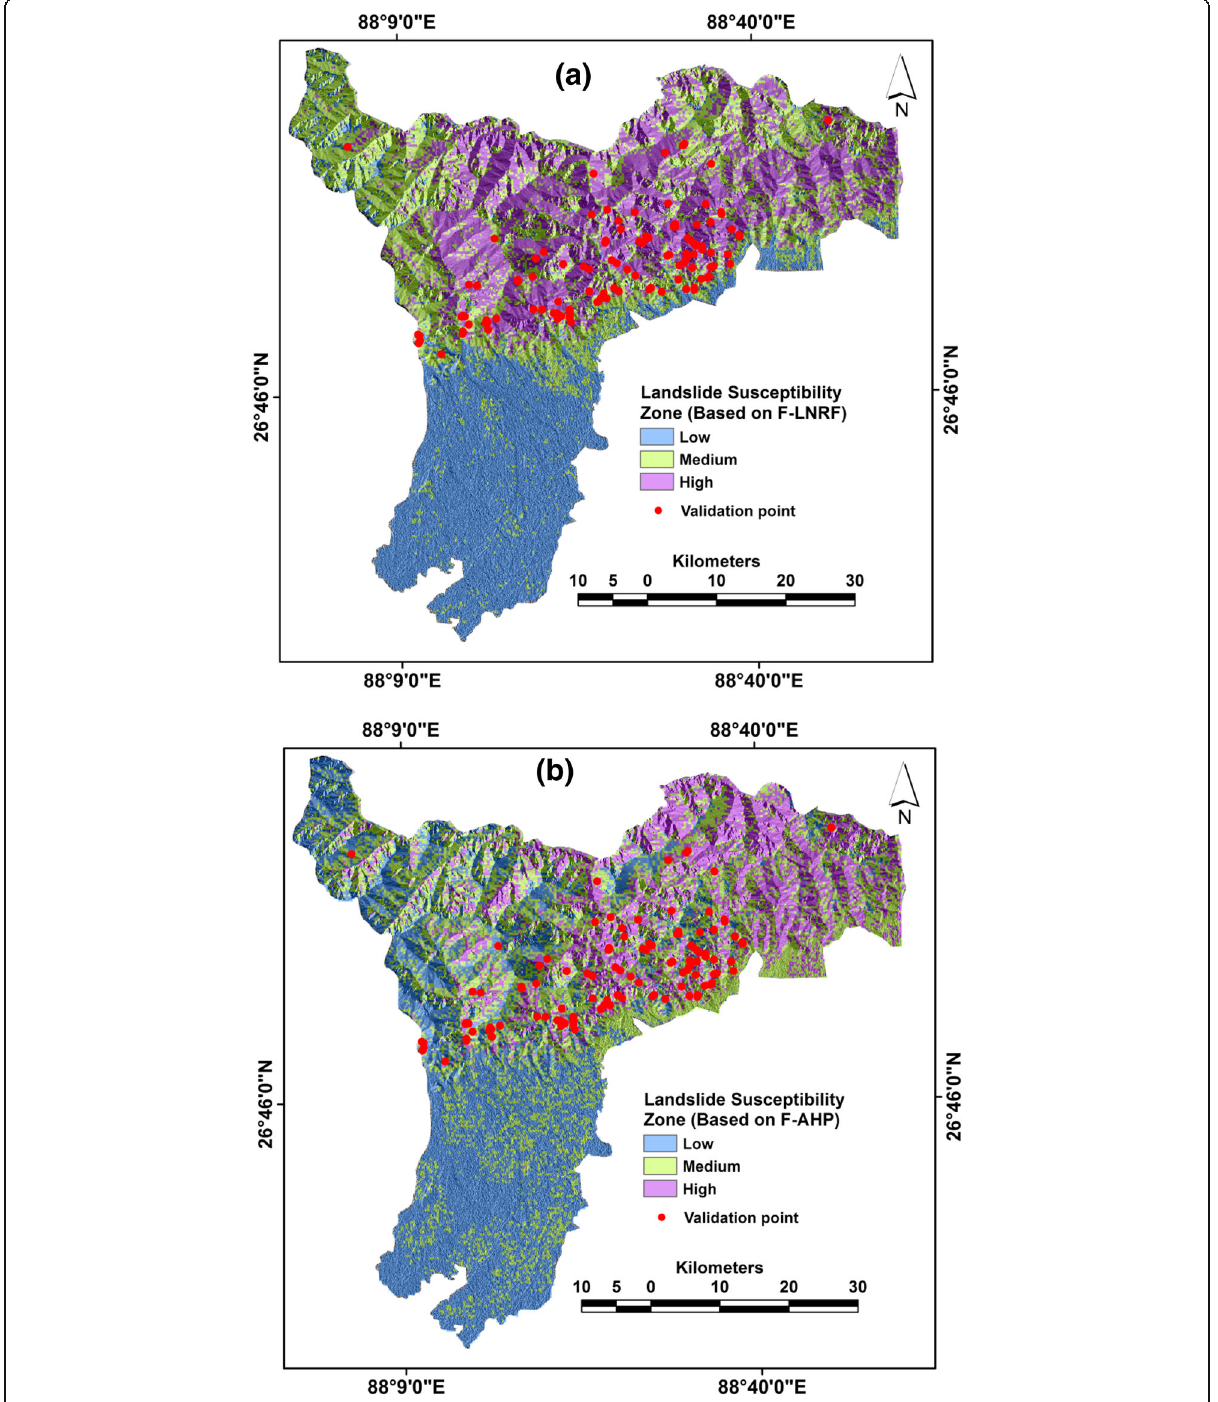
Fig. 4 Landside Susceptibility Maps ( a ) based on Fuzzy-LNRF model & ( b ) based on Fuzzy-AHP